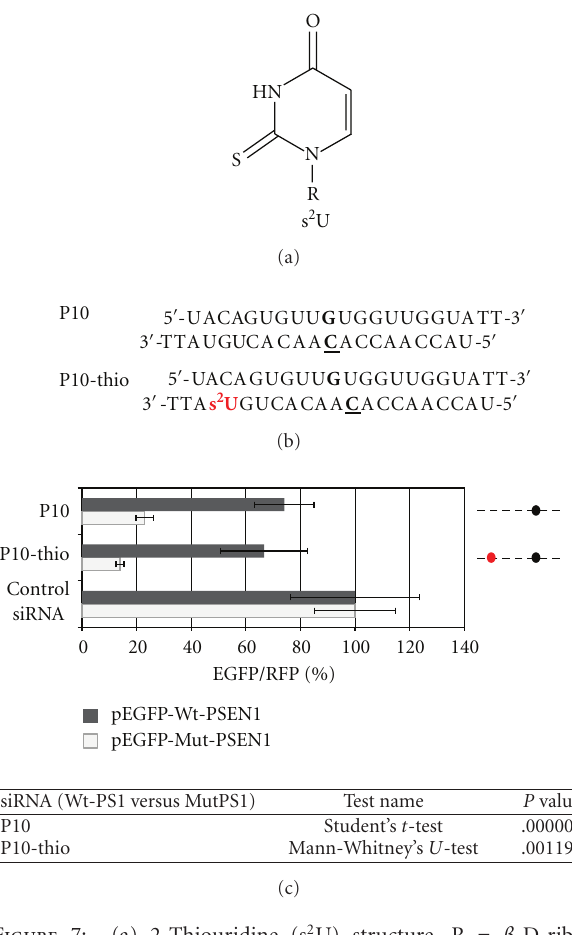
Figure 7: (a) 2-Thiouridine (s 2 U) structure, R = β -D-ribo- furanoside residue. (b) Sequences of the P10 and P10-thio modified siRNAs. (c) Comparison of the relative (EGFP/RFP) fluorescence in HeLa cells transfected with reporter plasmids: pEGFP-Wt- PSEN1(400) or pEGFP-Mut-PSEN1(400), pDsRed-N1 and siRNA: P10 and P10-thio (1nM). Dotted lines represent the antisense strands of the used siRNAs. Positions of the C-C mismatch between the guide strand of siRNA and the wild-type PSEN1 mRNA are indicated by the black dots. Red dot represents the site of the s 2 U modification at the antisense strand. The level of the relative EGFP/RFP fluorescence in cells transfected with control nonsilencing siRNA was used as 100%. Statistical analysis of di ff erences between two groups of data (Wt-PSEN1 versus Mut- PSEN1) were calculated by the use the Student’s t -test (for data with normal distribution) or by the nonparametric Mann-Whitney’s U - test. The di ff erences with P < . 05 were considered as statistically